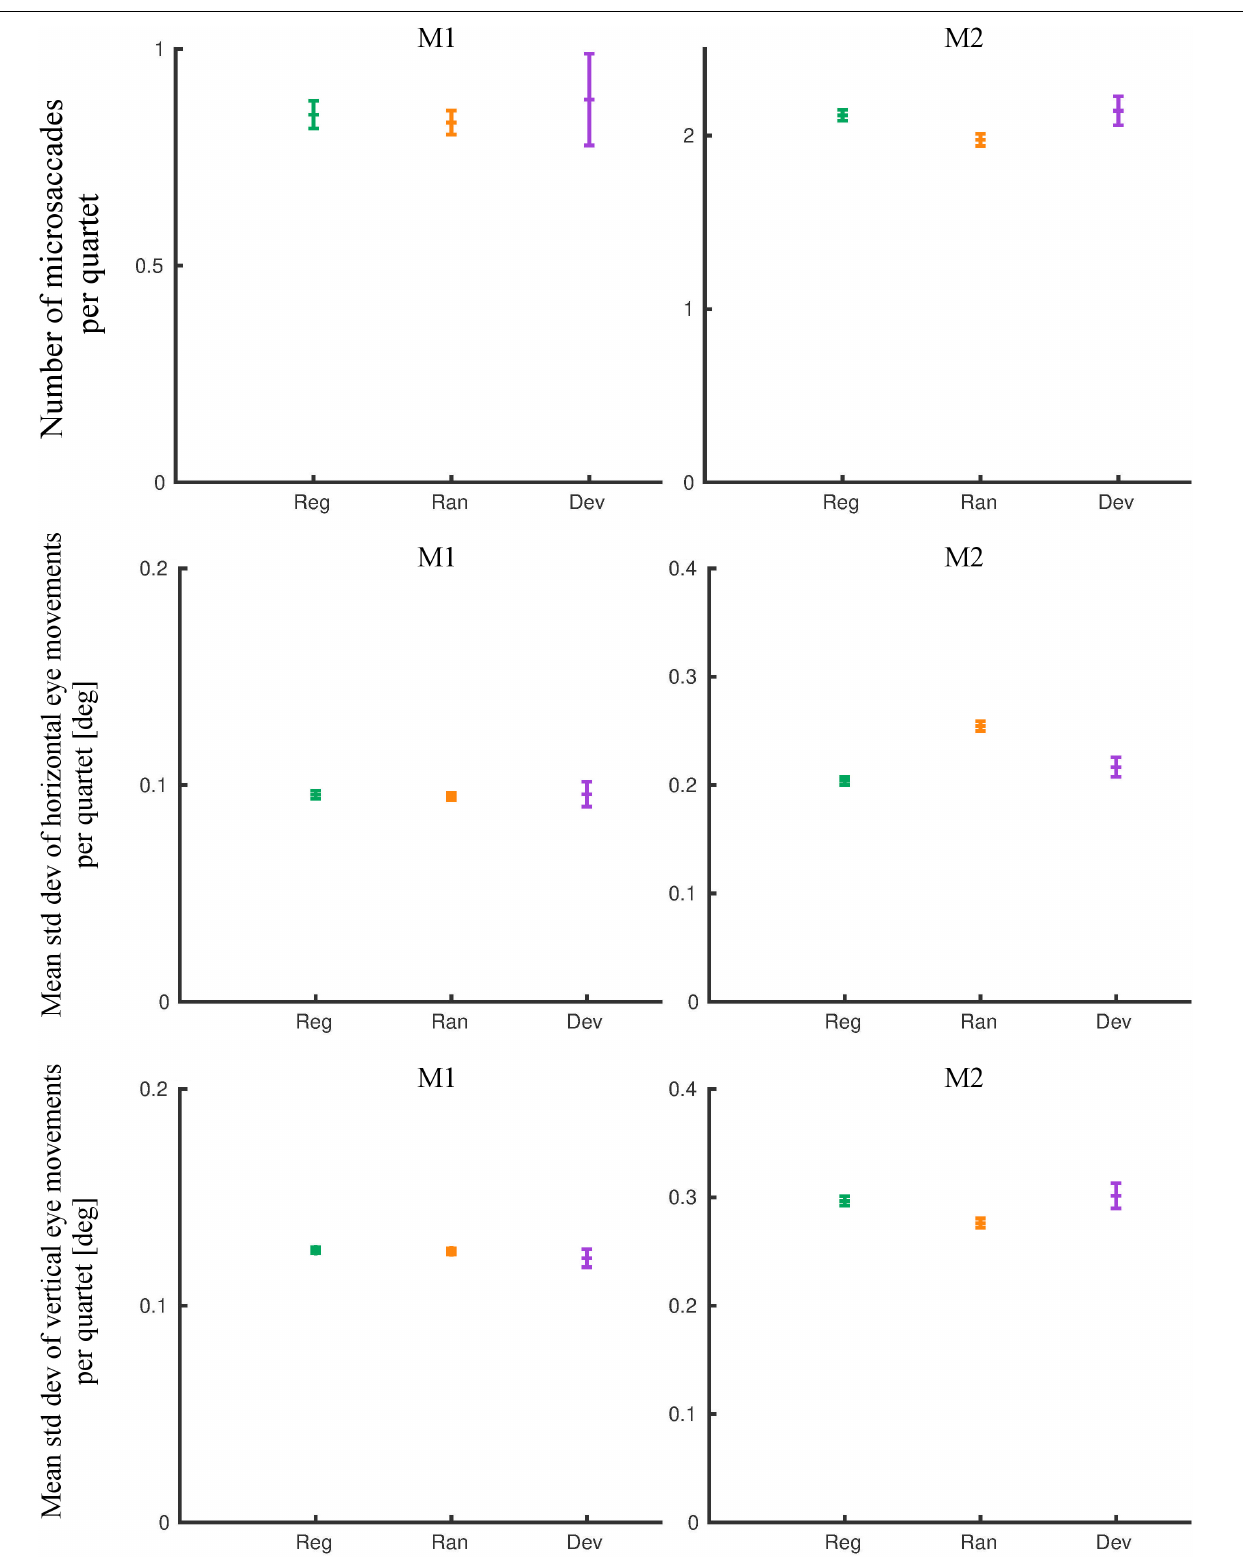
Frontiers in Neuroscience |